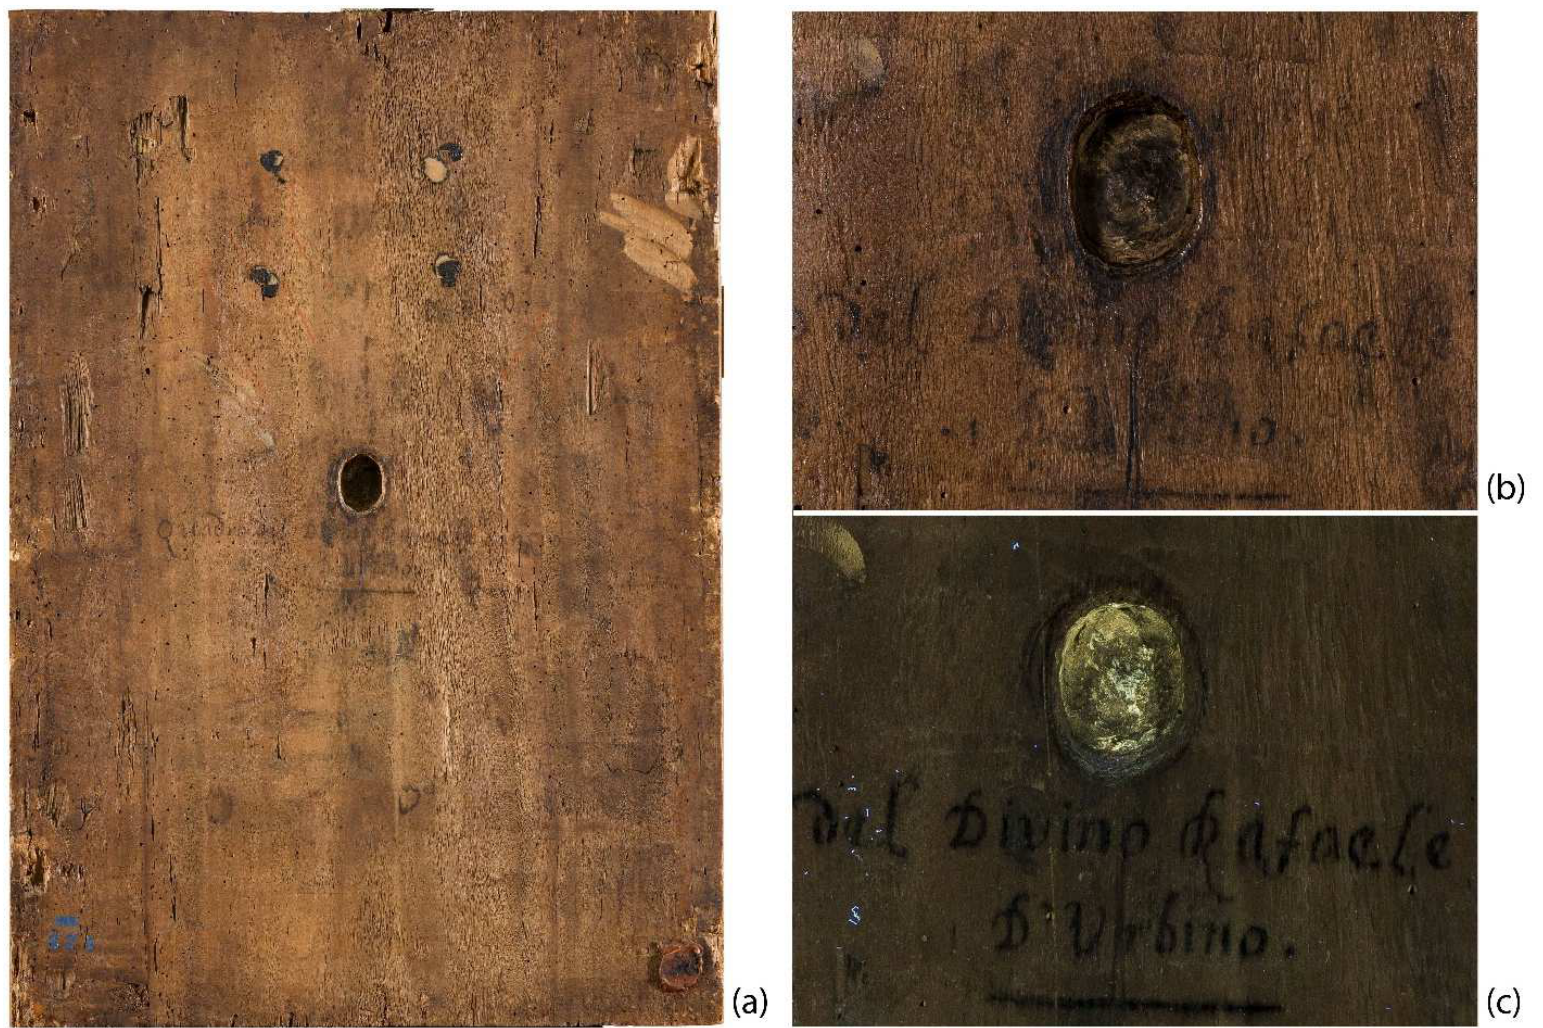
Figure 2. Back panel surface where the hollow and the handwritten inscription are visible ( a ); detail of the hollow under visible ( b ) and UV light ( c ).